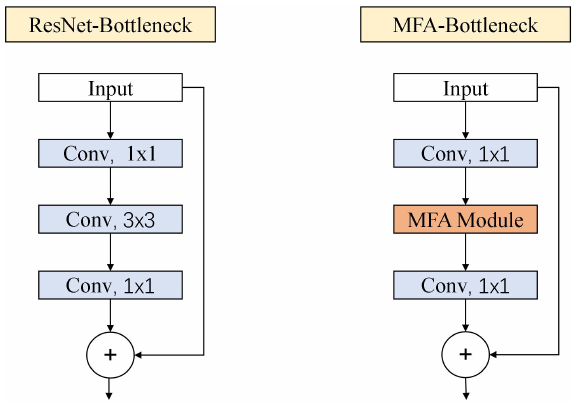
Figure 1. Illustrations and comparison of the ResNet block and MFANet block proposed in this